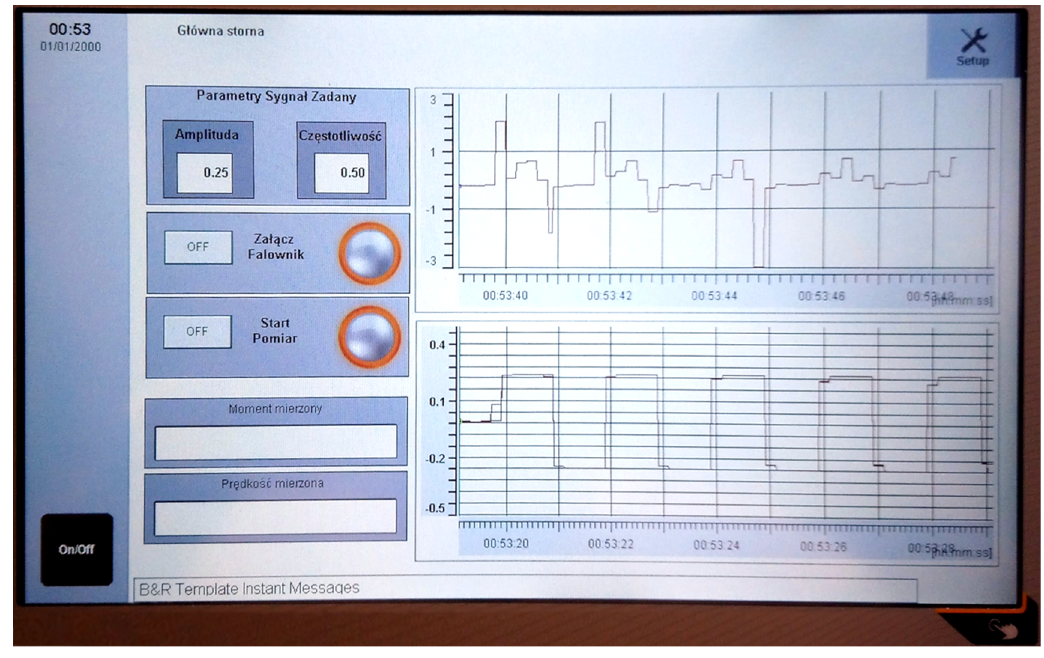
Figure 4. Operator panel with visualisation.